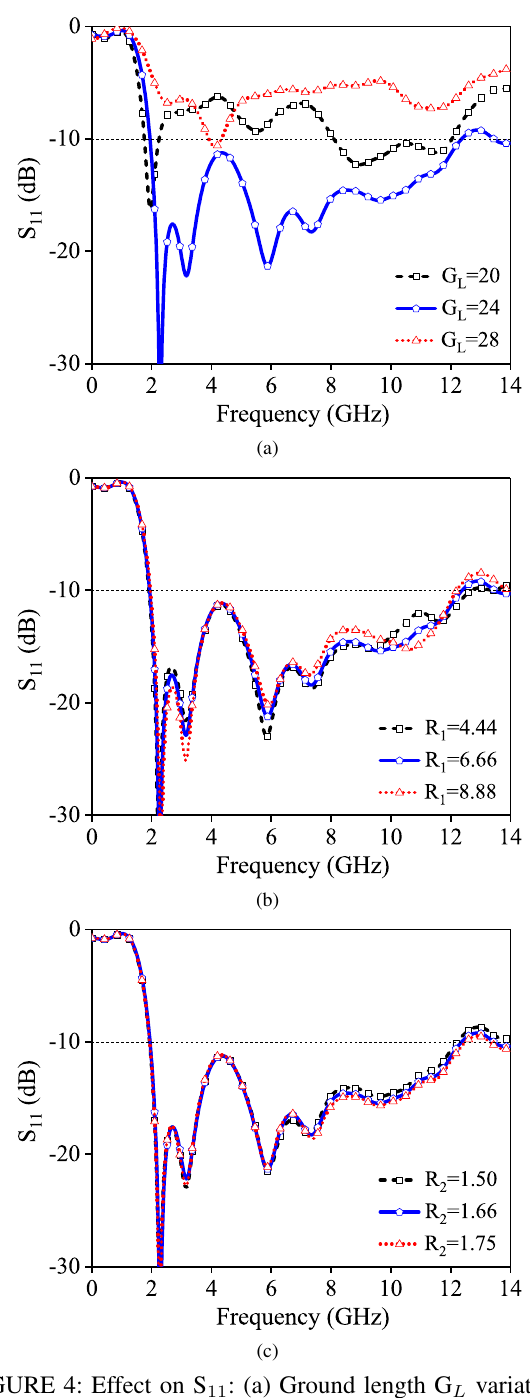
FIGURE 4: Effect on S 11 : (a) Ground length G L variation. (b) Top patch curve R 1 variation. (c) Ground notch curve R 2